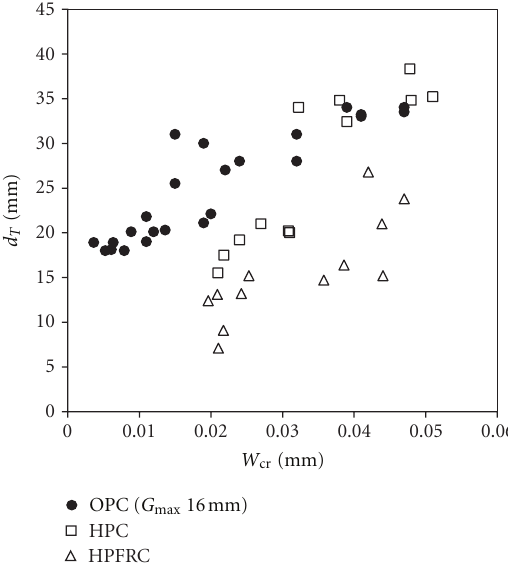
Figure 8: Chloride penetration depth versus crack width.